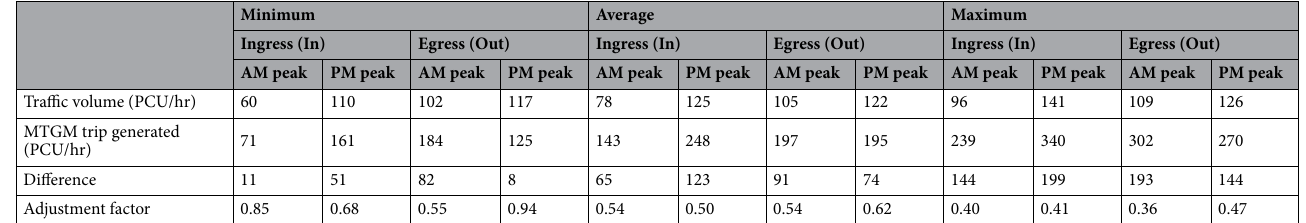
Table 5. Traffic volume, MTGM trip generated, and adjustment factor at 2nd MXD site (Site